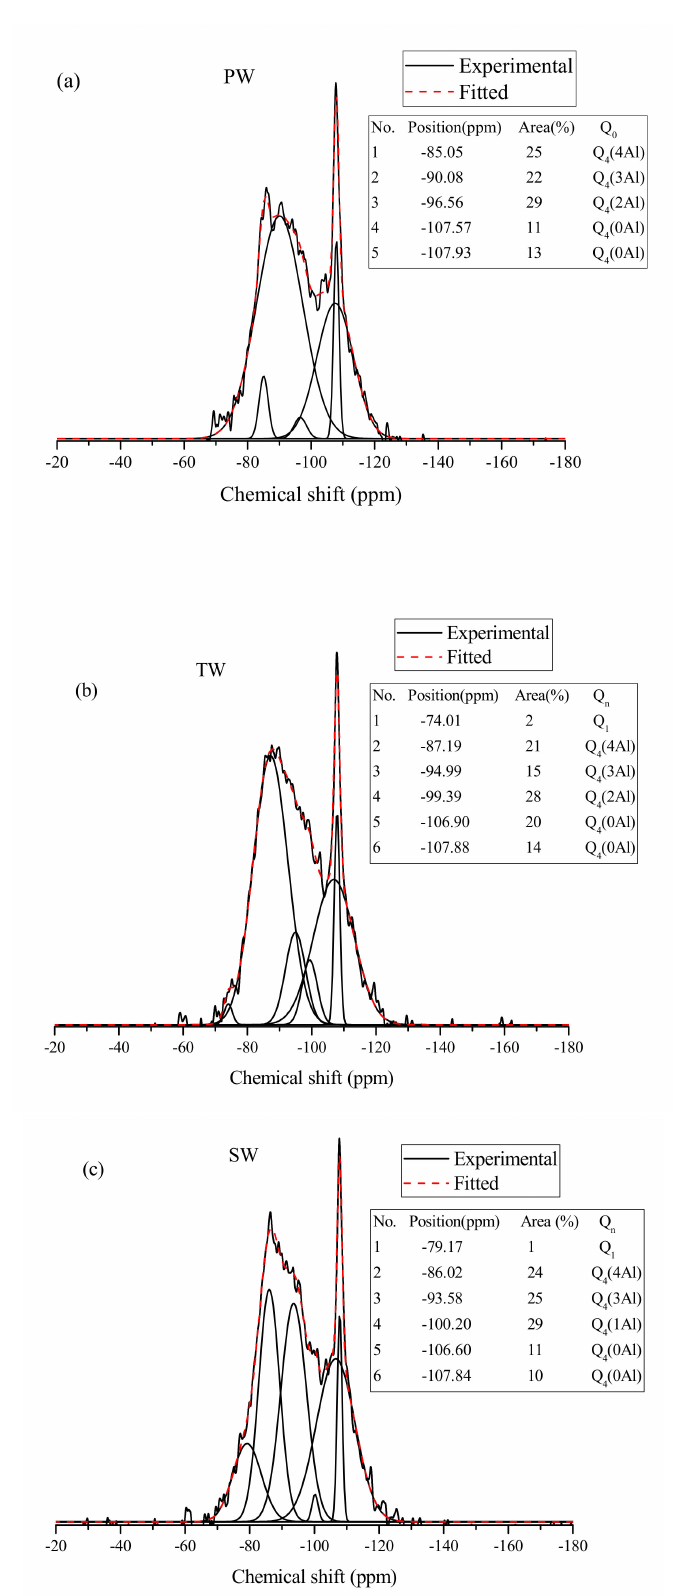
Figure 6. 29 Si NMR spectra and deconvolution results of AAM produced with di ff erent types of water: ( a ) PW mix, ( b ) TW mix, and ( c ) SW